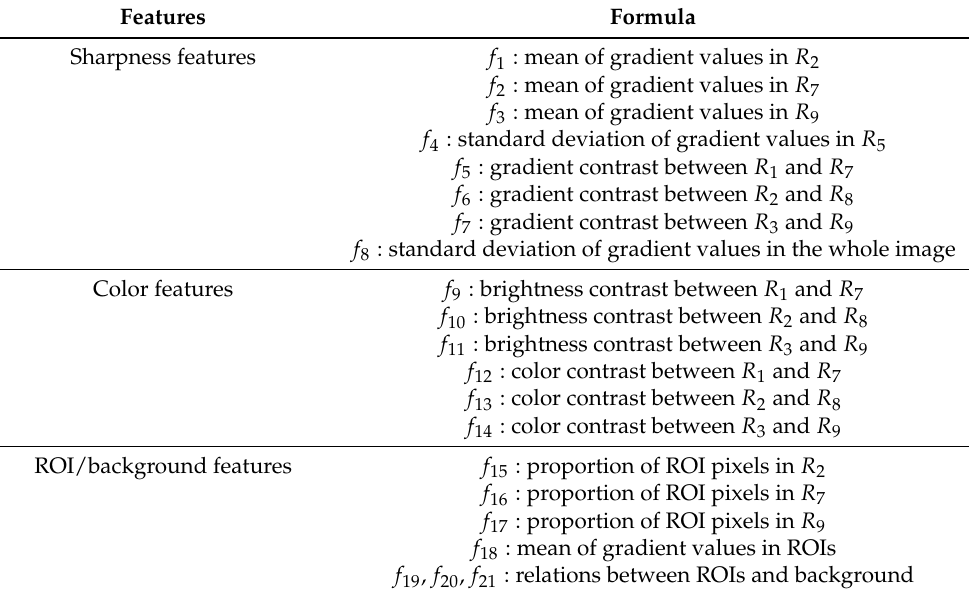
Table 1. Overview of the proposed handcrafted features for LCIC. R 1 , R 2 , . . . R 9 are the regions split by the rule of thirds (see the top right photo in Figure